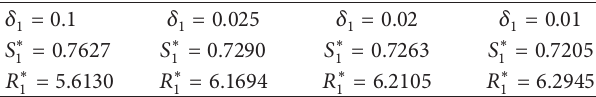
Table 1: Values of (𝑆 ∗ 1 , 𝑅 ∗ 1 ) , when fixing 𝛿 2 = 0.012 and changing 𝛿 1 .